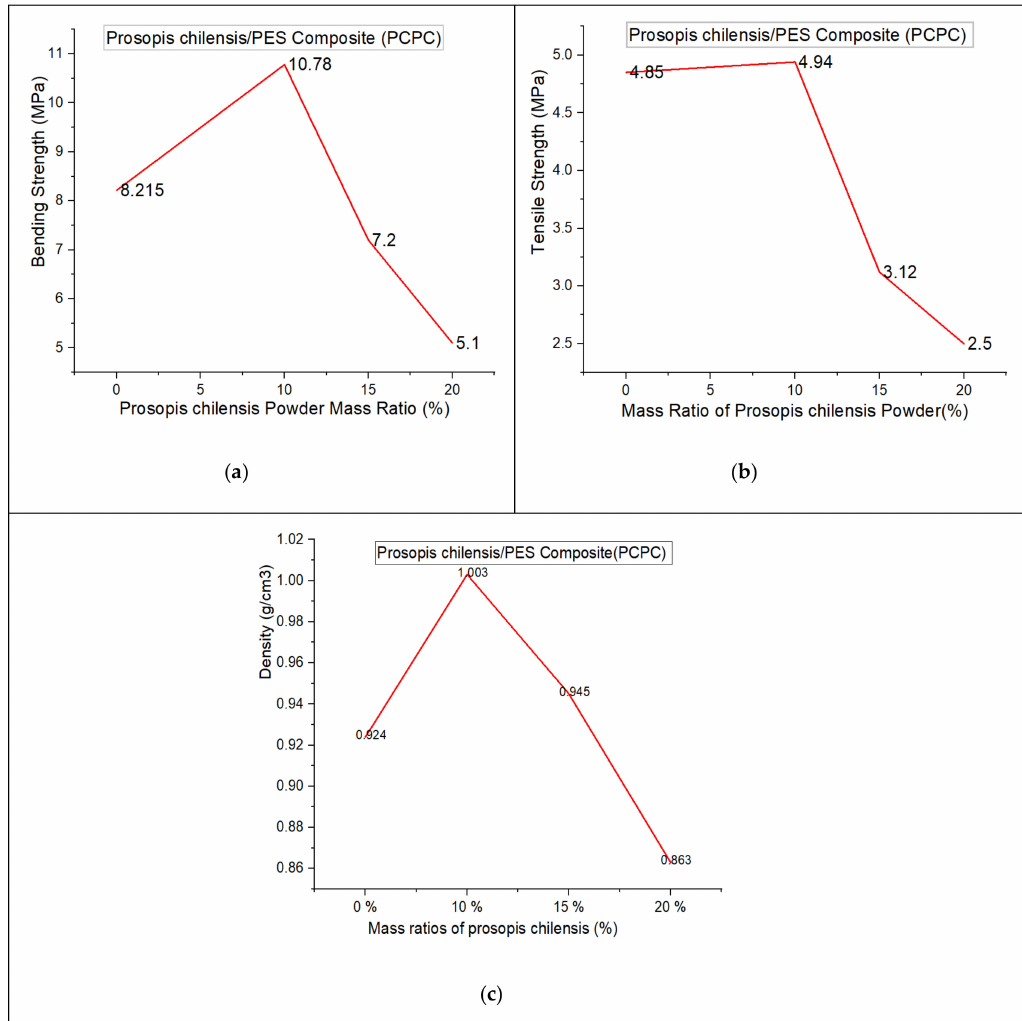
Figure 10. Mechanical properties of the PCPC parts with varying mixture ratios, namely, ( a ) bending strength, ( b ) tensile strength, and ( c ) density. (Note: zero mass ratio represents a pure PES sintered